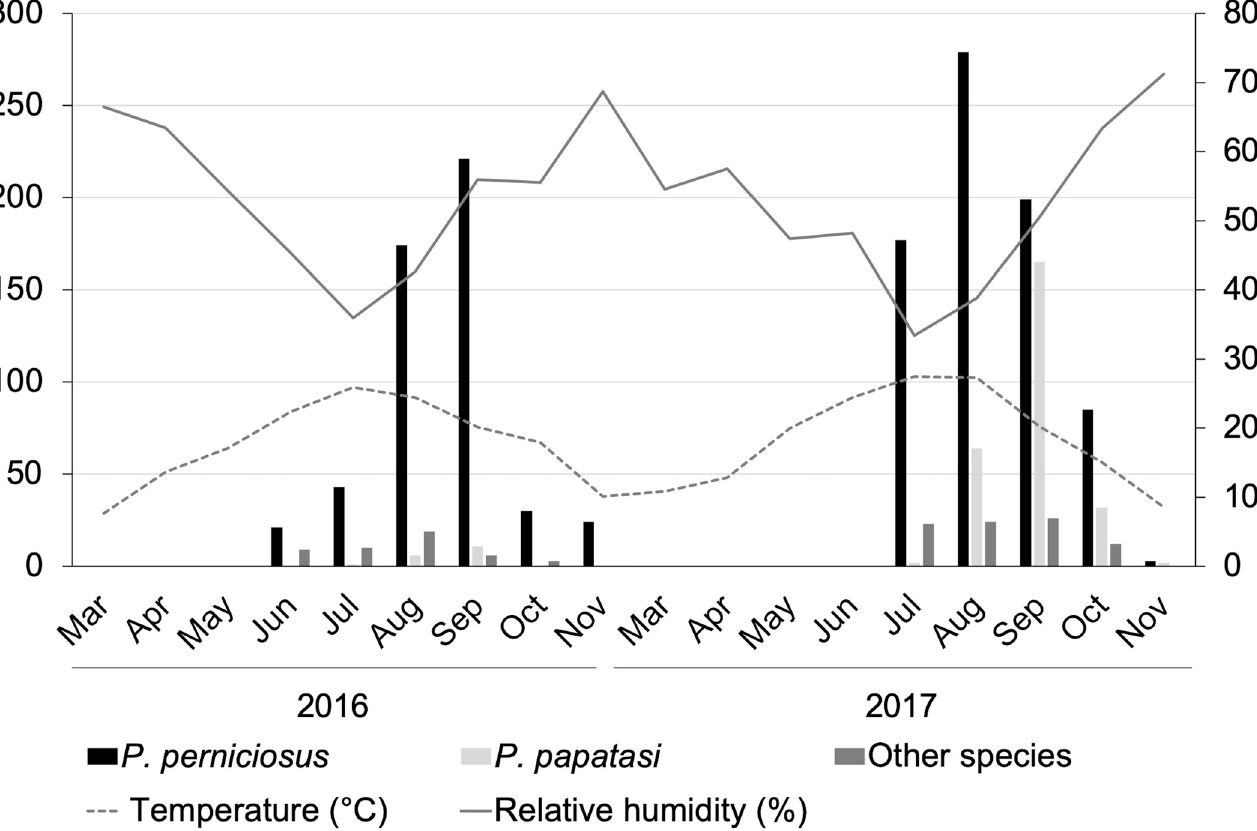
Fig 4. Monthly dynamics of sand flies ( Phlebotomus perniciosus , Phlebotomus papatasi , and remaining species combined) in Setif province, North-Eastern Algeria, 2016–2017, in relation to temperature and relative humidity. https://doi.org/10.1371/journal.pntd.0008024.g004 were registered in five rural areas (i.e., sites A–E) and in two urban (i.e., sites F, G) and peri-